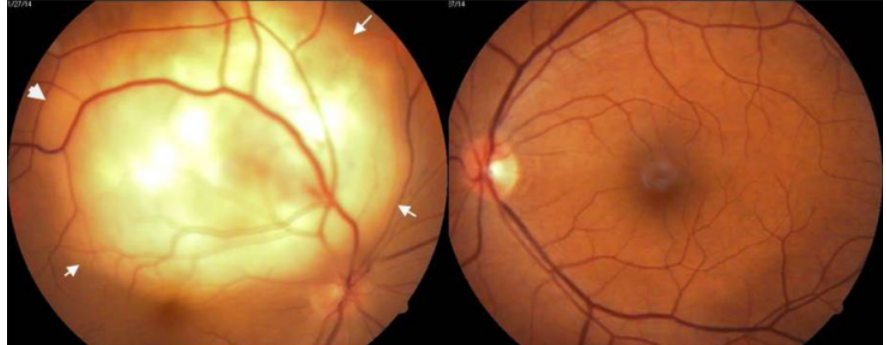
Figure 1: RE showing subretinal mass lesion. White arrows demarcating the outline of retinal detachment.